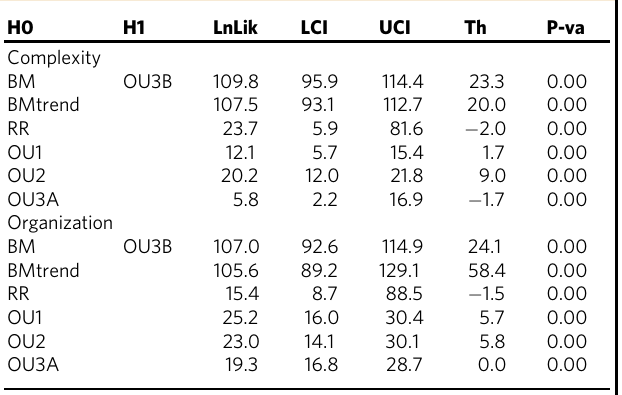
Table 3 Hypothesis tests of OU3B (H1) against various null models (H0) for the whole vertebra